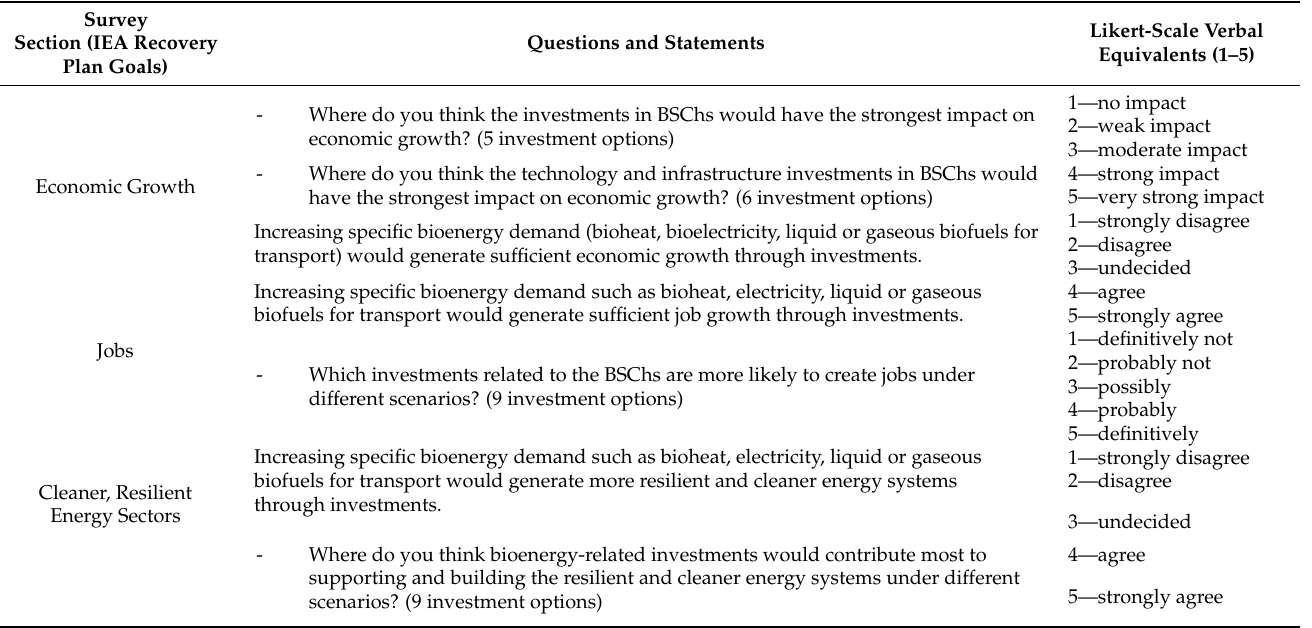
Table 1. Survey sections, investment statements, and verbal equivalents of the 5-point Likert-scale to collect experts’ opinion, both in short- (by 2023) and long-term (by